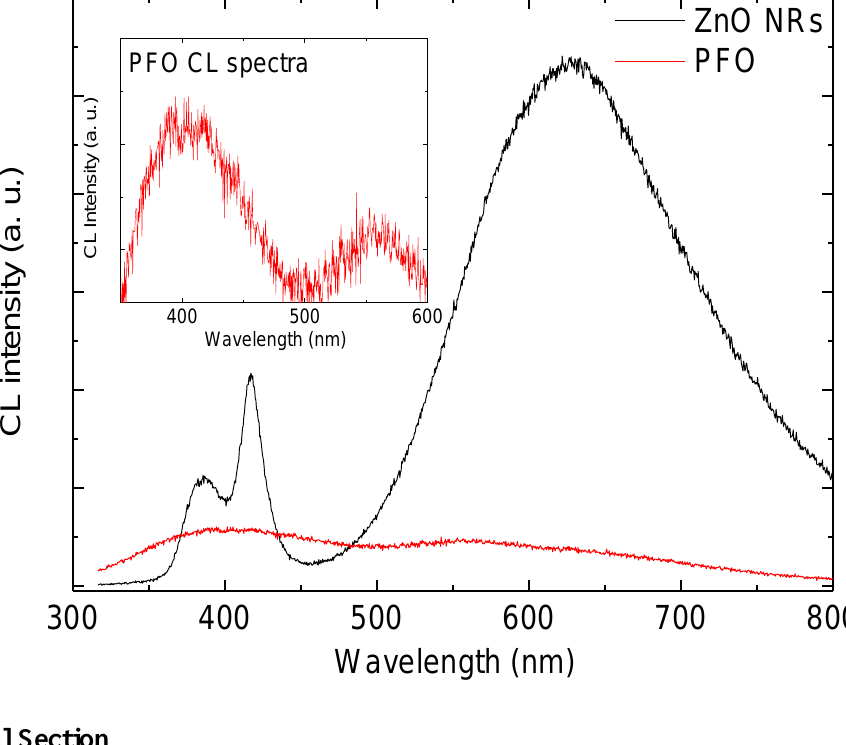
Figure 7. Comparison of the CL emission spectra from the hybrid LED and an area with PFO only; inset shows the magnified CL emission spectra of